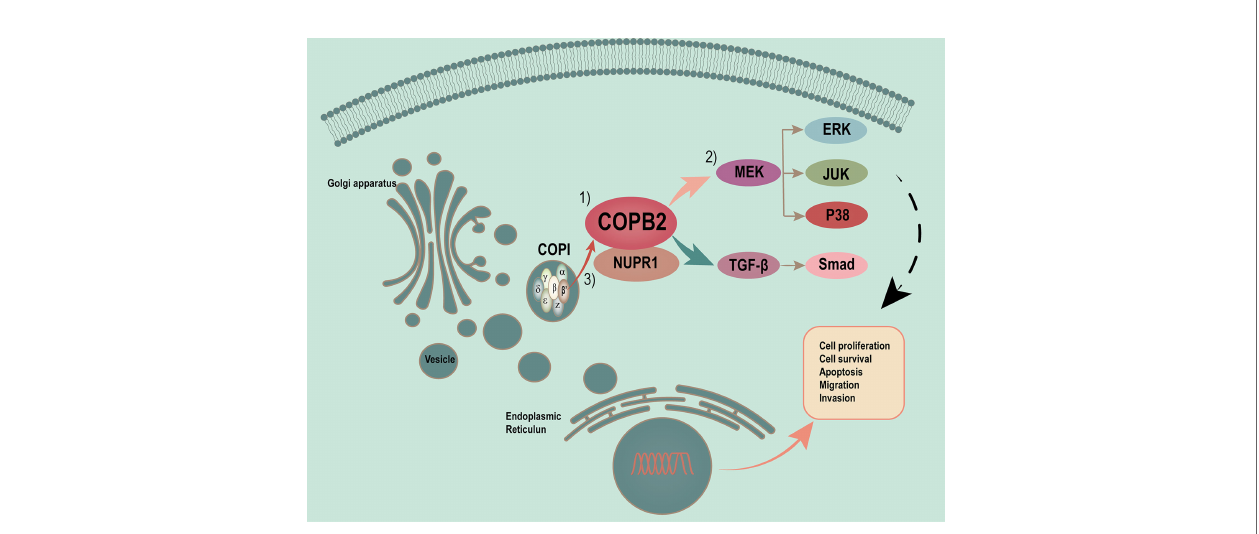
FIGURE 10 | Proposed model of MAPK/TGF- b /COPB2/NUPR1 axis in control cell proliferation, migration and invasion in PCa cells. Vesicles plays a critical role in membrane transport between ER and Golgi apparatus. COPI-coated vesicles, which contain seven non-clathrin-coated vesicular coat subunits, play its function in the early secretory pathway. COPB2 is one of subunits involving in transport between ER and Golgi. After many researches have been done, we have identi fi ed the differential and functional COPB2 protein. On one hand, the COPB2 can be as a molecular to be secreted to serum and be considered as a biomarker to detect some potential PCa patients. On the other hand, more important, COPB2 can promote cell proliferation, migration and invasion via MAPK/TGF- b signaling pathway in PCa. The least but not the last, COPB2 can interaction with NUPR1 , which is a transcription factor associated with cancer development and